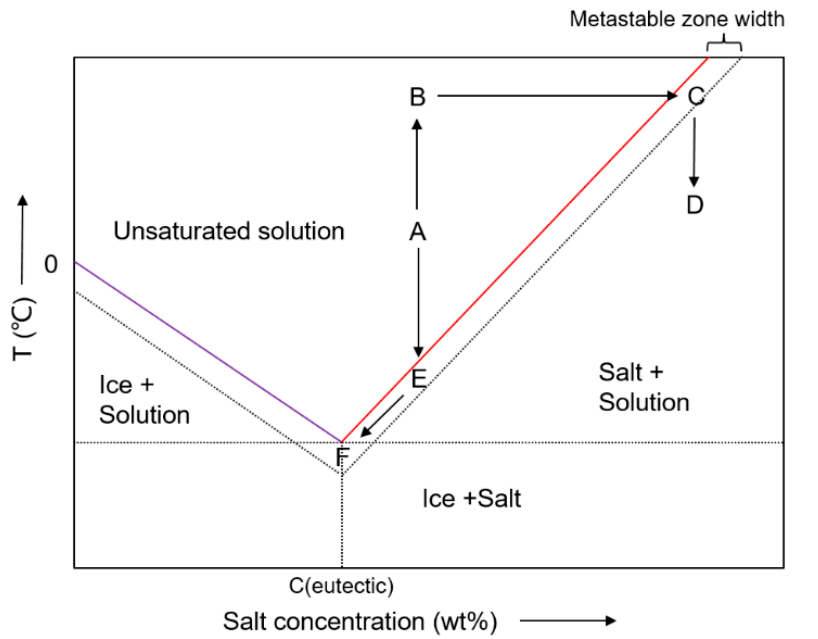
Figure 3. Phase diagram of a binary salt-water system.